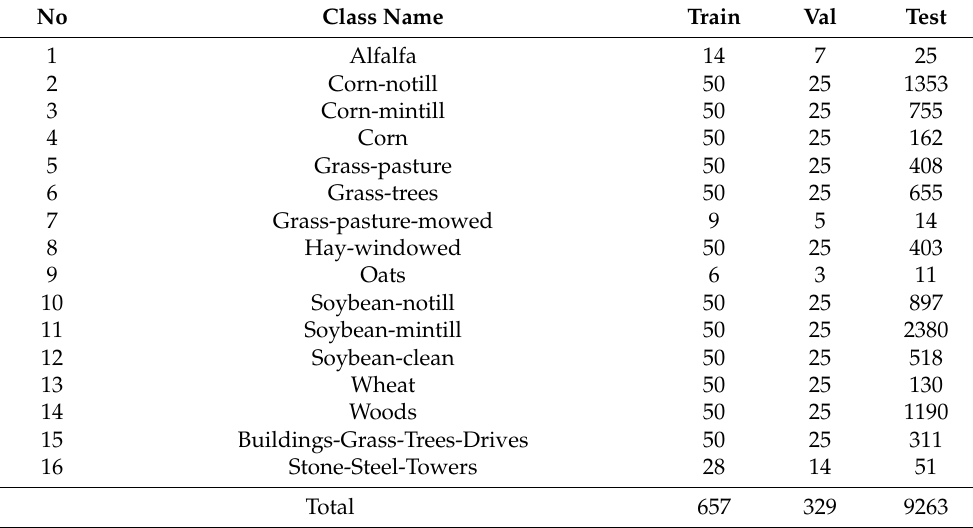
Table 3. The number of training, validation, and testing samples in the IP data set.